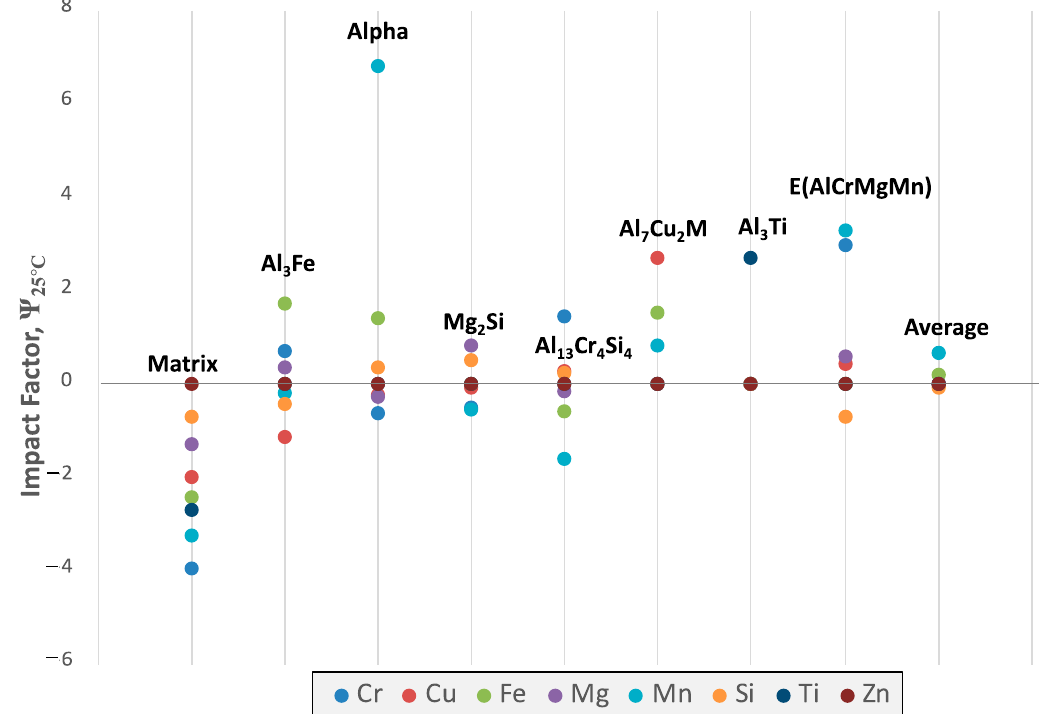
Figure 21. Compilation of the 𝜓 s for the matrix and most abundant secondary phases present in Al 6061 at 25 °C.